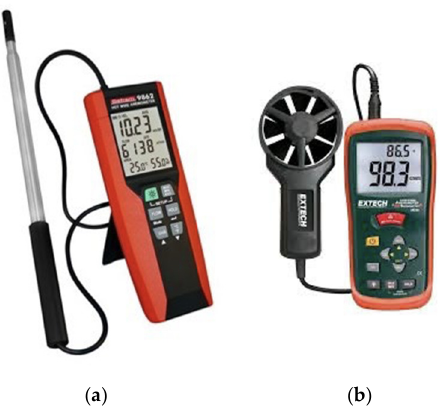
Figure 5. Measurement tools: ( a ) Hot wire anemometer; ( b ) vane anemometer. The area outside the window, the window sill, the two bedrooms, and the living room were used as the measuring points for the field measurement (Figure 6a). The fourth floor is the first floor that has no obstructions (trees, buildings, etc.), the tenth floor is one of the floors in the middle of the building (read vertically from building section), and the fifteenth floor is on the top floor (Figure 6b), with the metric units facing the wind tunnel area and the urban area (Figure 6c).